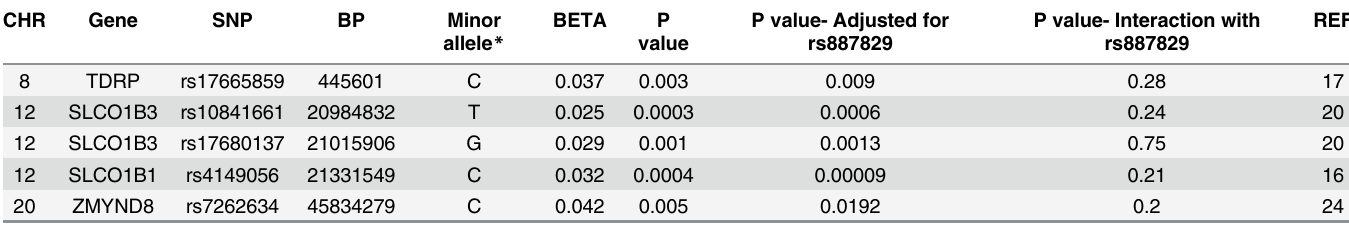
Table 3. Other effects associated with total serum bilirubin at FDR <